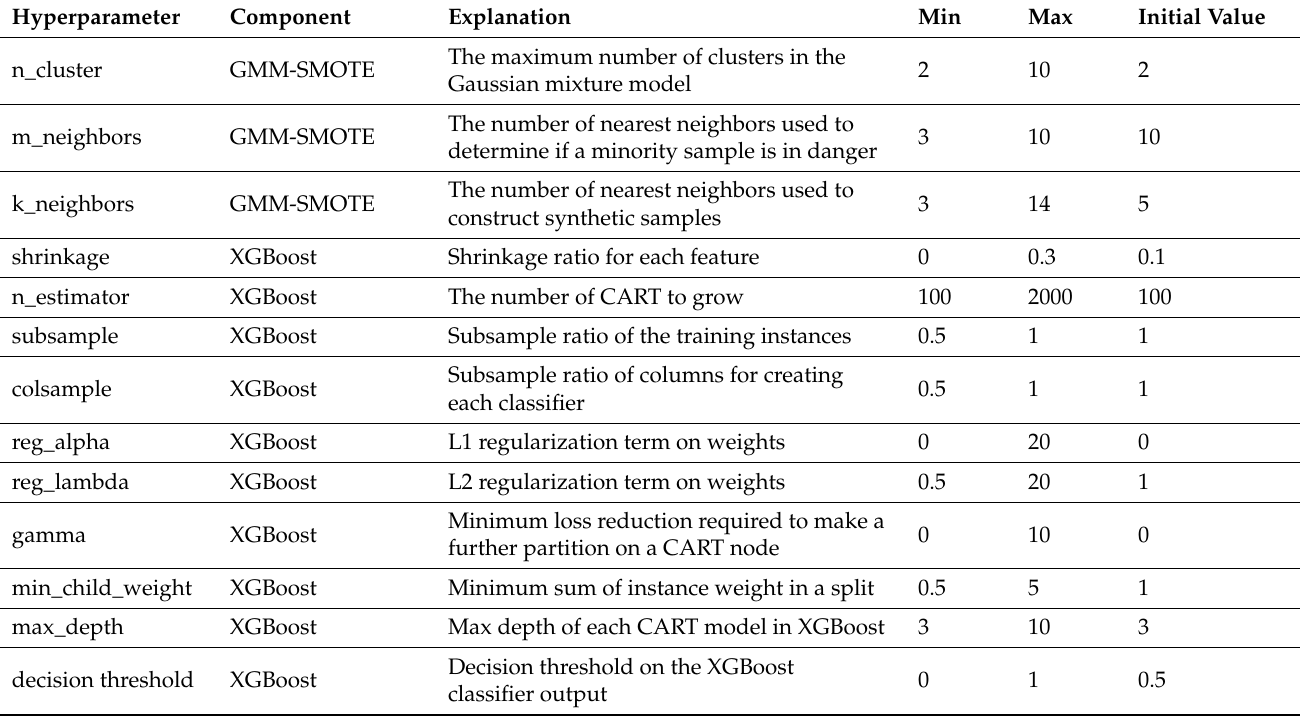
Table 2. Hyperparameters, their searching space defined by the minimum and maximum, and the initial values. Hyperparameter